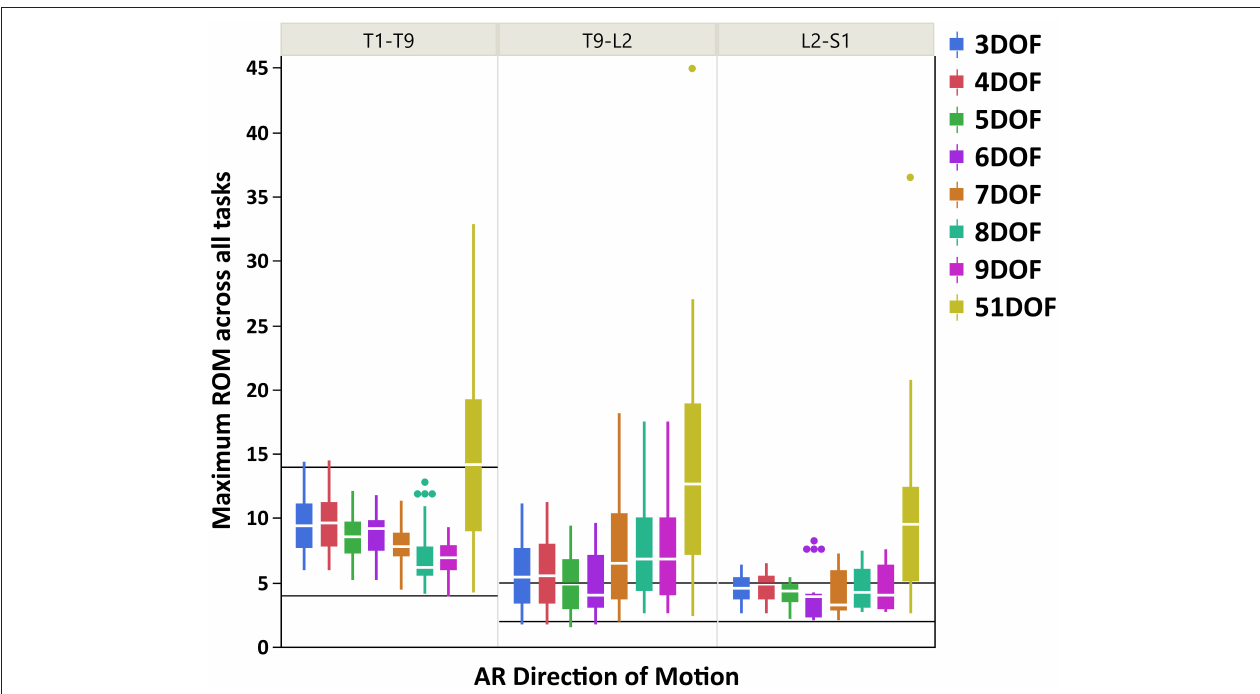
FIGURE 5 | Boxplot of maximum ROM of 17 intervertebral joint angles, grouped in three spine regions [i.e., “T1-T9”: T1/T2 to T8/T9; “T9-L2”: T9/T10 to L1/L2; “L2-S1”: L2/L3 to L5/S1], for all kinematic constraints [3–9DOF and no constraint (51DOF)] in AR direction of motion. The black lines horizontally overlaid on each panel plot are minimum and maximum ROM of intervertebral joints for the corresponding spine regions in AR direction of motion, reported by White and Panjabi (1978) . ROM, range of motion; DOF, degrees of freedom; AR, axial